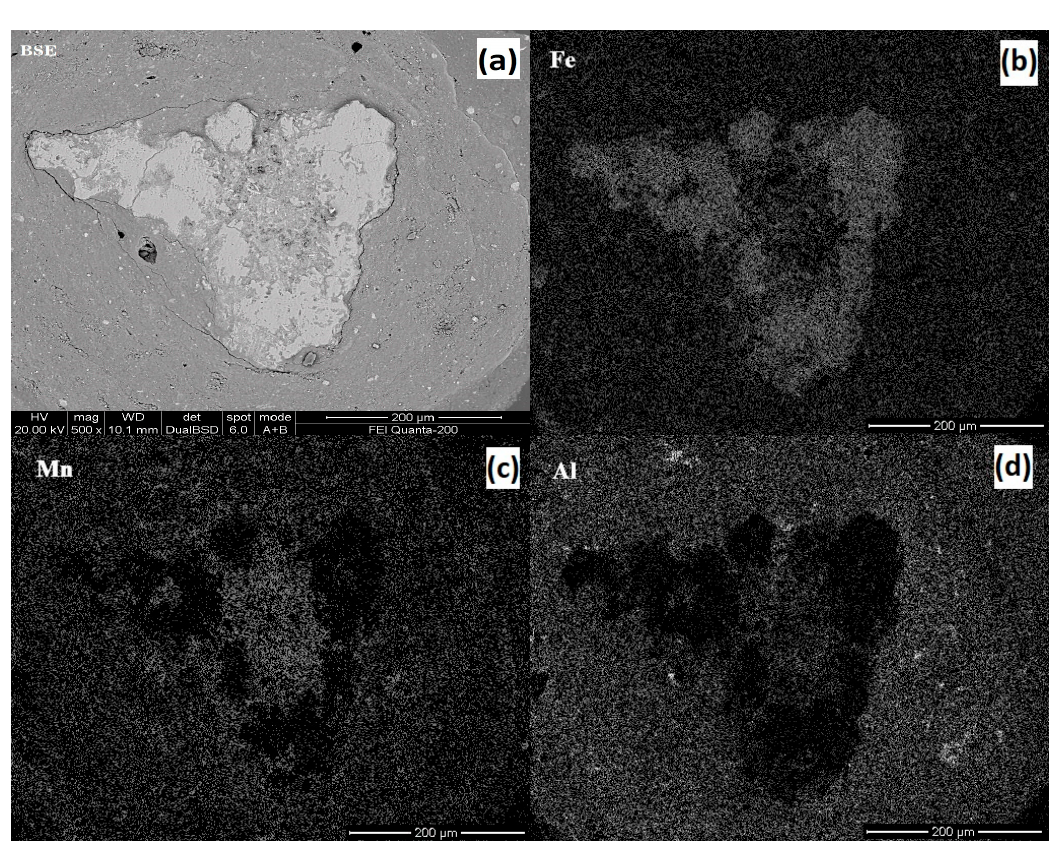
Figure 1. X-ray diffraction (XRD) pattern of high-aluminum iron ore (HA ore) and high-maganese iron ore (HM ore).